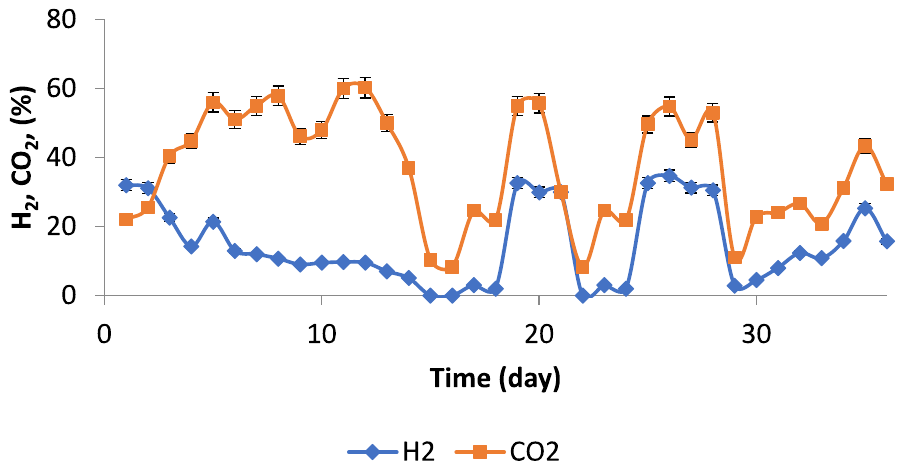
Figure 8. Volume content of H 2 and CO 2 in the biogas from BR 1 in the continuous mode of TPAD of CSL.